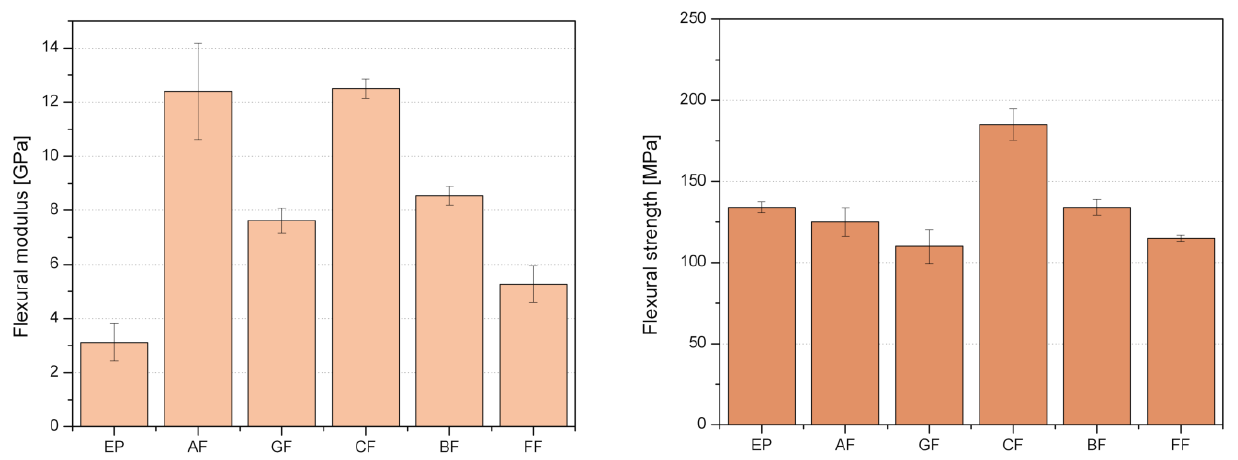
Figure 9. Mechanical properties of EP and EP-composites obtained from the flexural test.